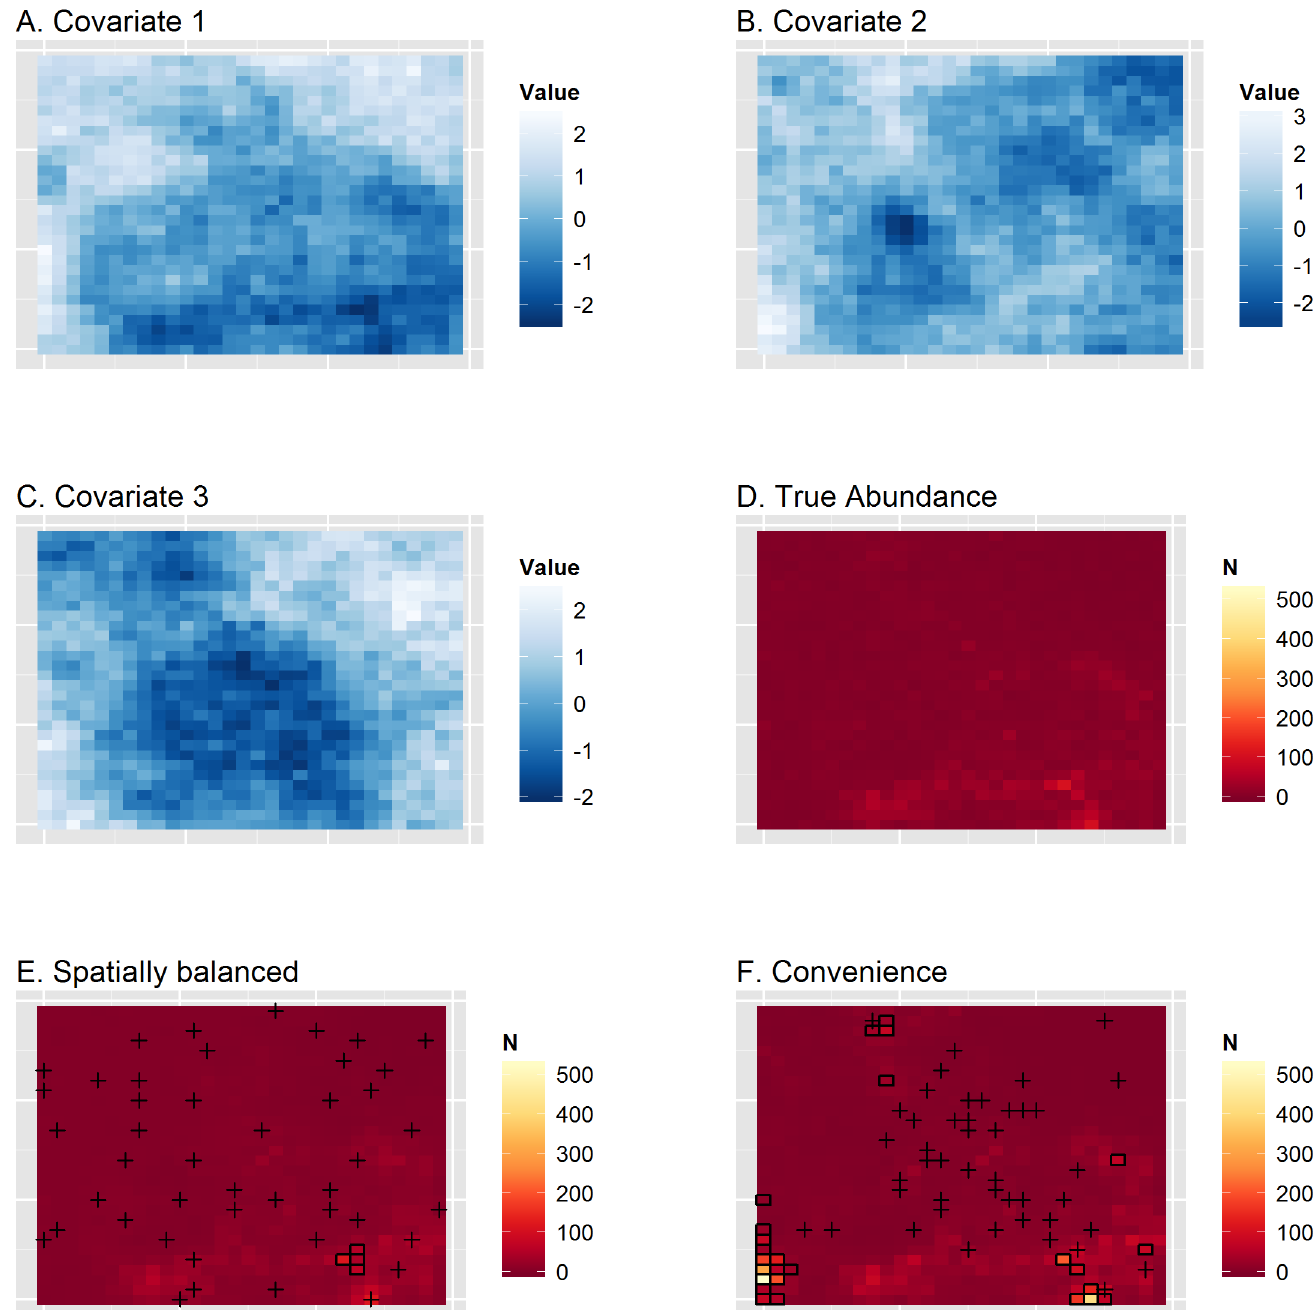
Fig 2. Depiction of a single simulation replicate where problematic extrapolation occurs. Panels (A-C) give simulated covariate values, panel D gives true animal abundance, (E) gives estimated abundance from a GLM run on count data from a spatially balanced survey design, and (F) gives abundance from a GLM applied to count data from a convenience survey. In (E-F), predictions outside the gIVH are represented by black boxes, and sampling locations are represented with an x. For the convenience sample, there was considerable positive bias, particularly in cells outside of the gIVH. In this case, the median posterior abundance prediction for the entire survey area is 57% greater than true abundance when inference is made to the whole study area. When inference is restricted to cells within the gIVH, median posterior abundance is 16% greater than true abundance.